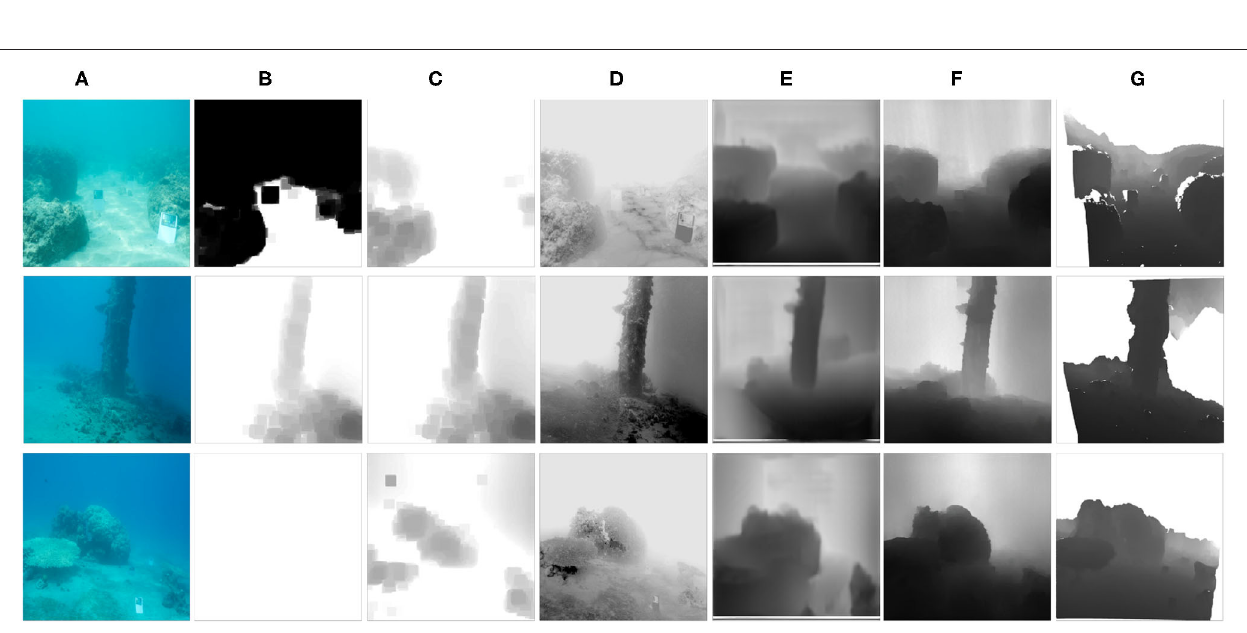
FIGURE 4 | Comparison of our method with other underwater depth estimation methods. From left to right, (A) are real underwater images from the dataset of Berman et al. (2017), (B–F) are the results of DCP (He et al., 2010), UDCP (Drews et al., 2016), Berman et al. (2017), Gupta and Mitra (2019), and our method, and (G) are the ground